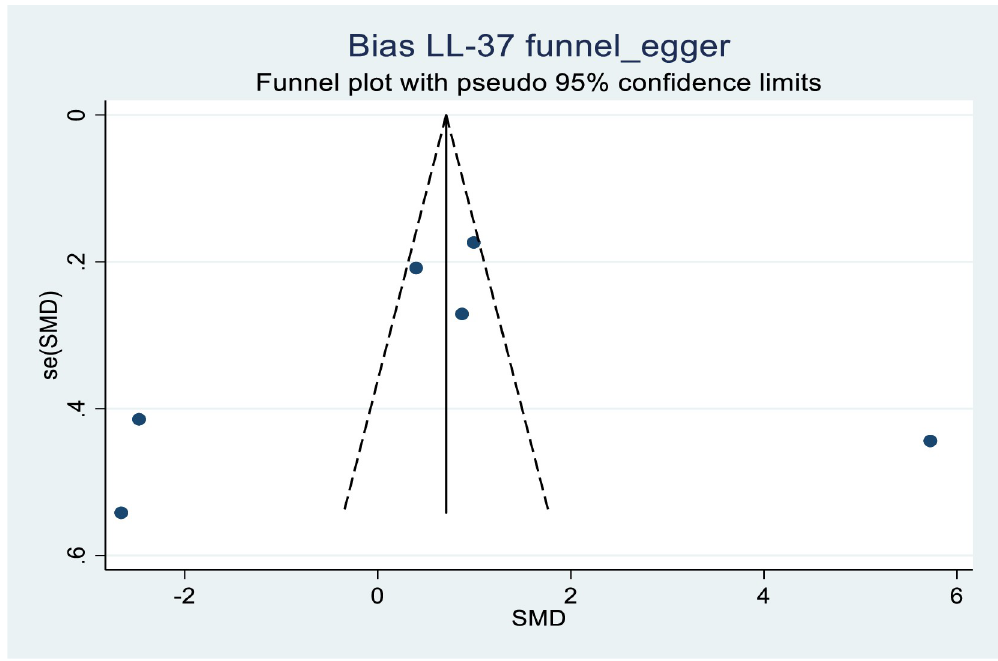
Fig 5. Funnel plot of standard mean difference of LL-37 levels against standard error of mean difference at CI 95%, in six highly scattered studies due to publication bias.